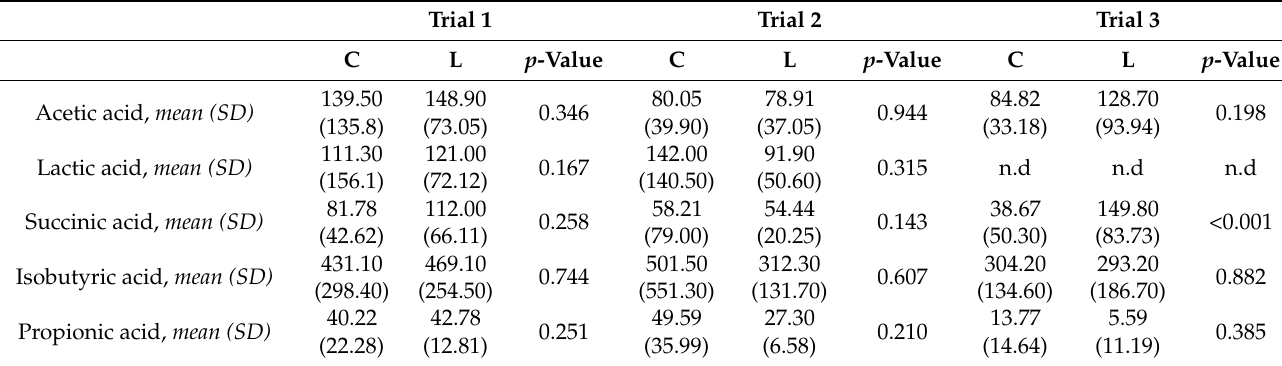
Table 7. Faecal short-chain fatty acids detected in trials 1, 2 and